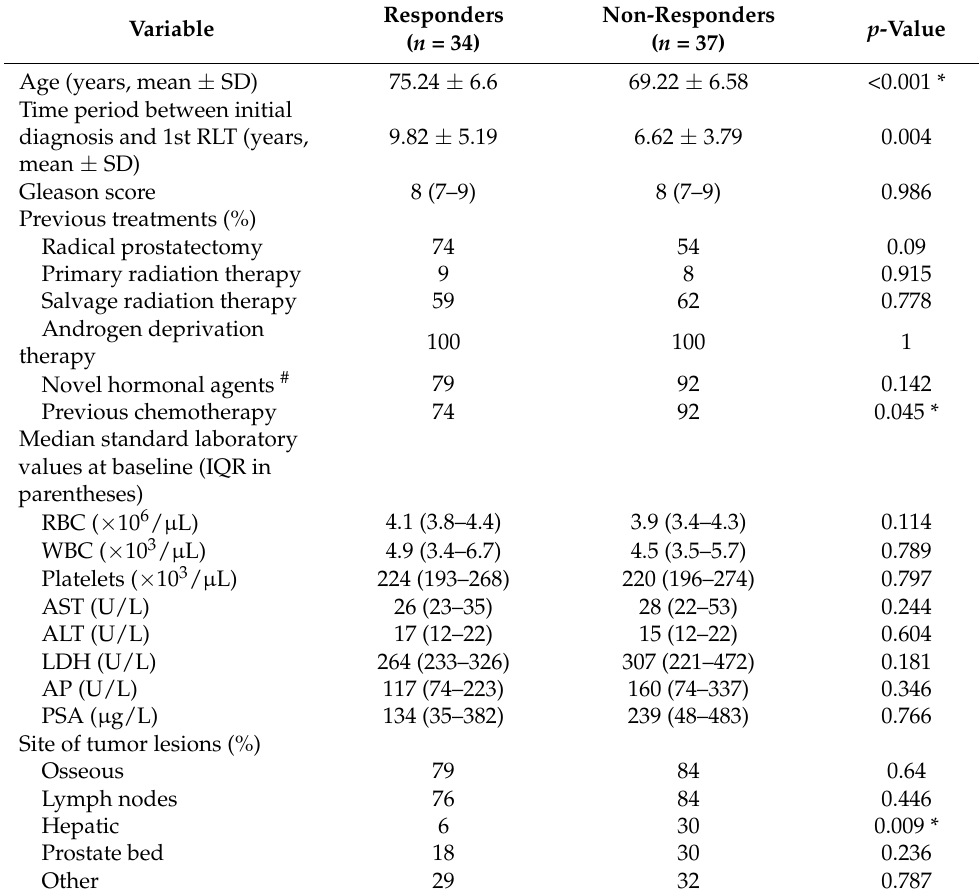
Table 1. Patient